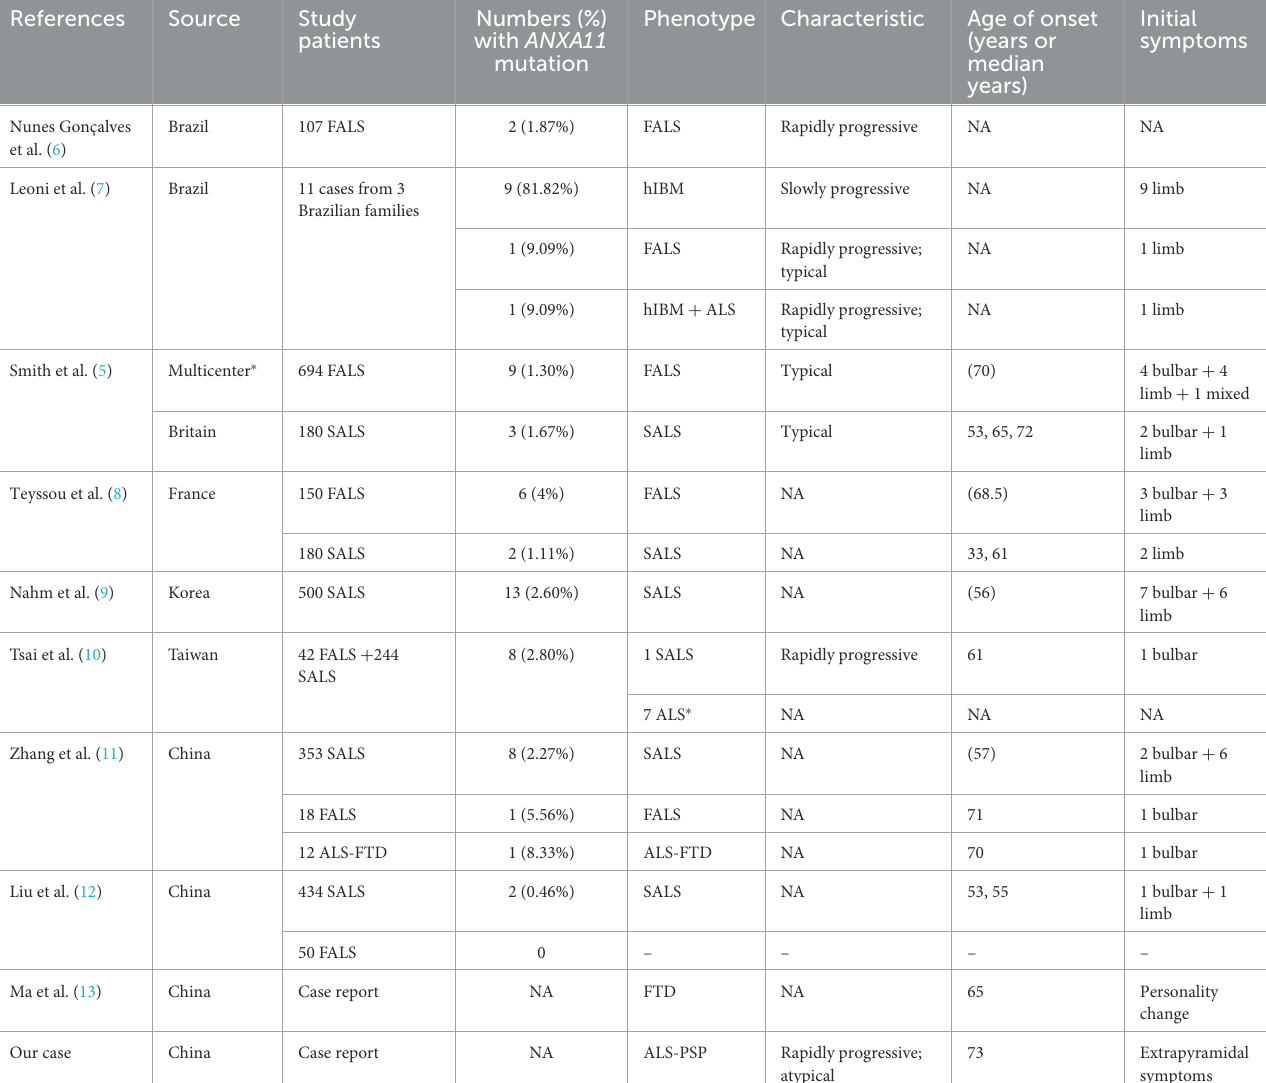
TABLE 1 Clinical phenotypes of 68 patients with ANXA11